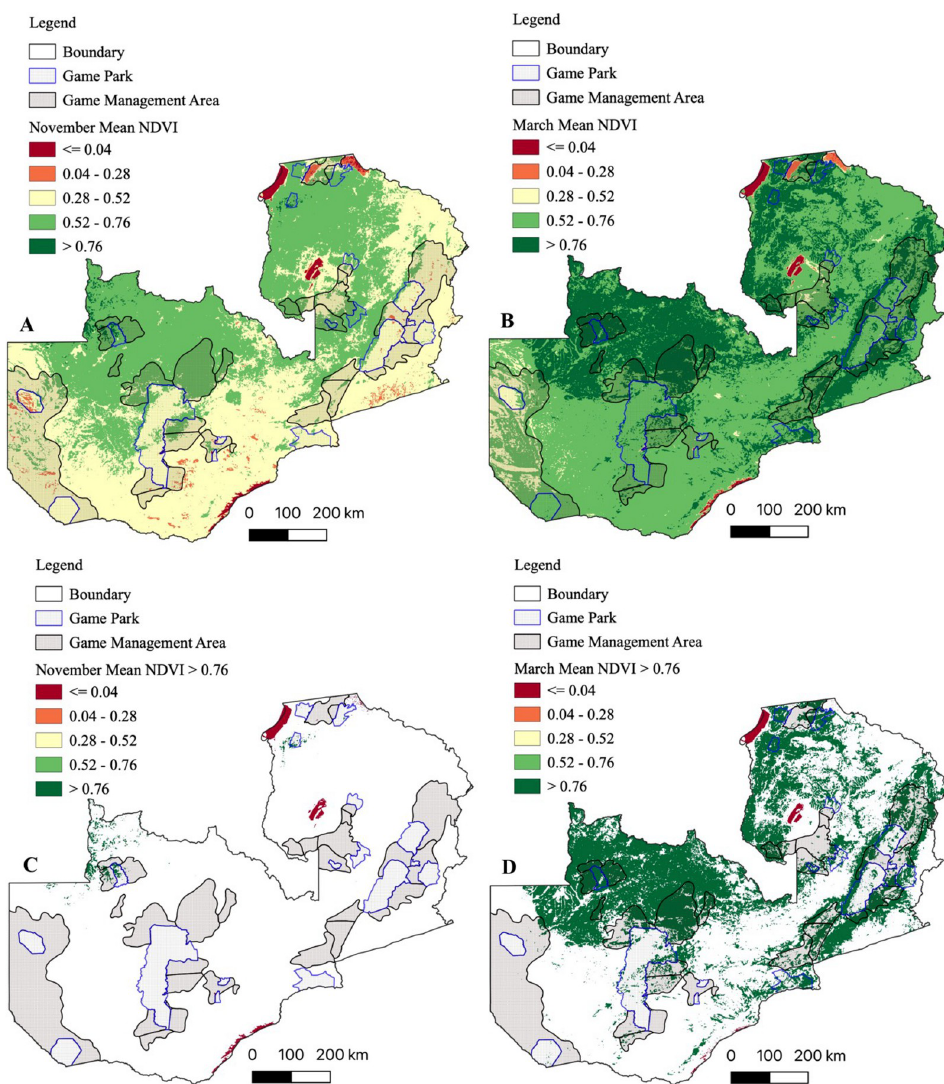
Fig 4. Mean normalized difference vegetation index (NDVI) for November and March. NDVI were computed as means for the period 2000–2019. (A & C) NDVI for November at the onset of the rainy season. (B & D) NDVI for March at the end of the rainy season showing anomalous (NDVI > 0.76) vegetation growth. Shapefile republished from DIVA-GIS database (https://www.diva-gis.org/) under a CC BY license of Global Administrative Areas (GADM), copyright